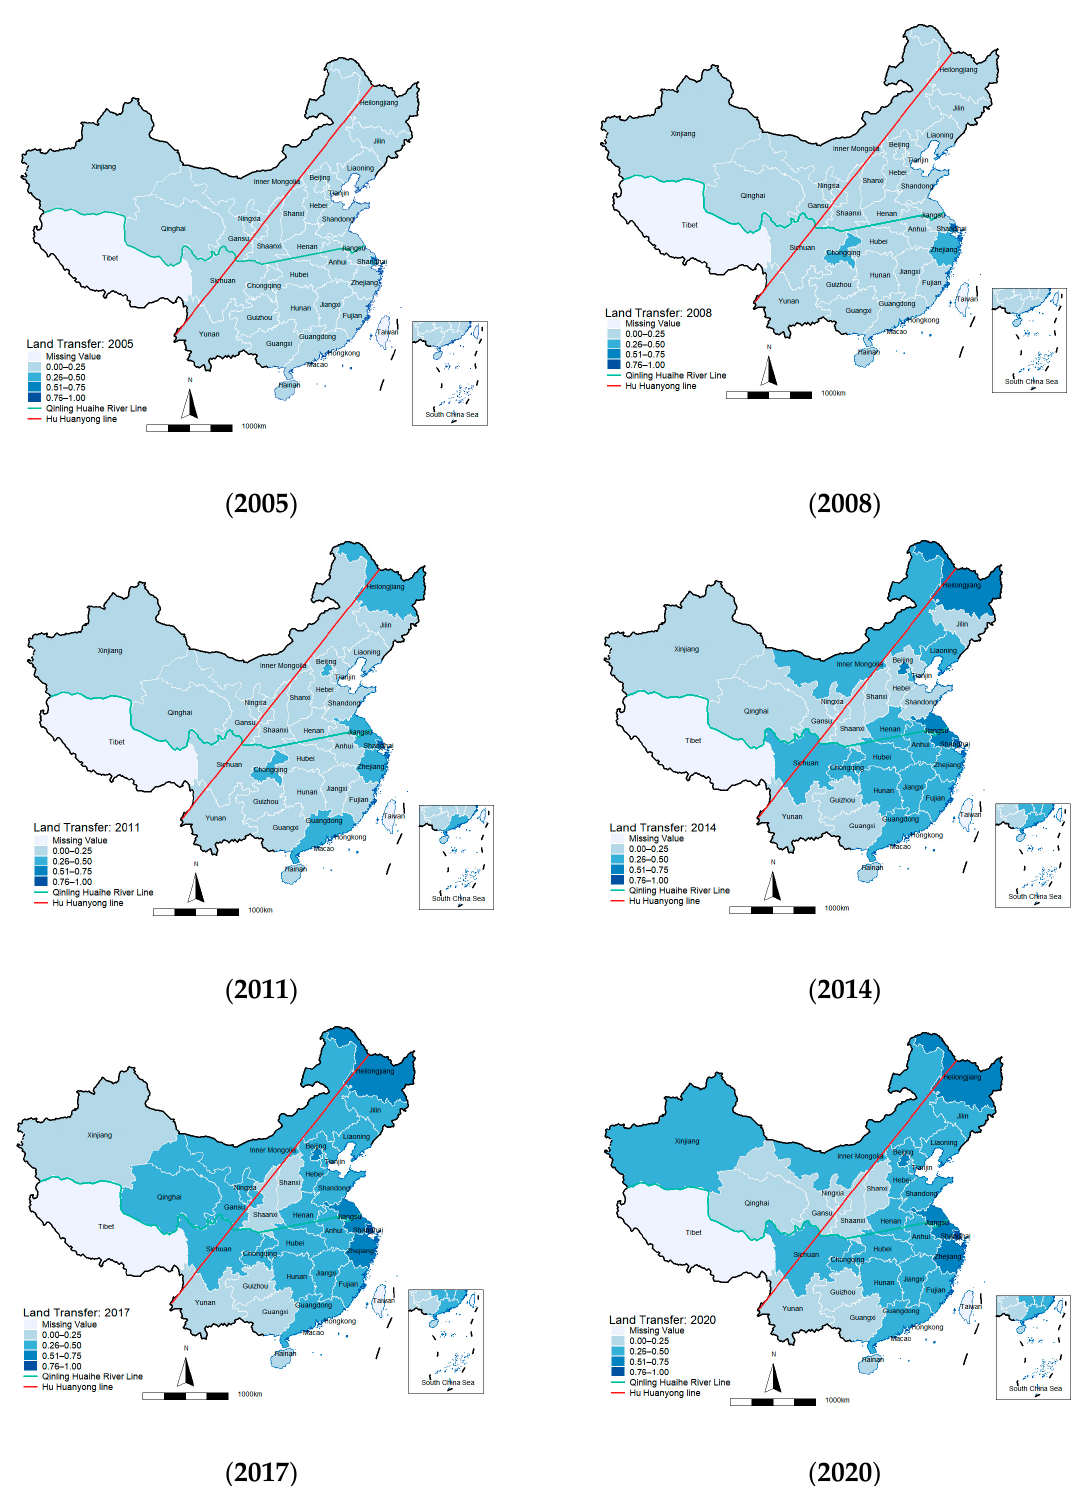
Figure 1. Land transfer proportion in rural China from 2005 to 2020.